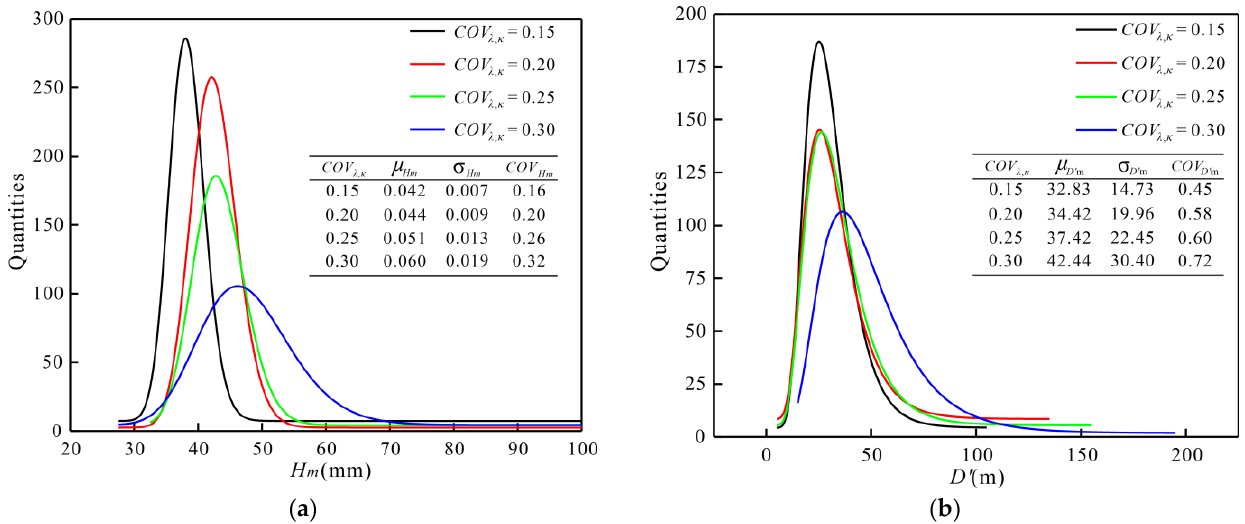
Figure 18. Effect of COV λ , κ on the PDF curves of probabilistic analysis of ground surface settlement of the excavation: ( a ) PDF of H m ; ( b ) PDF of D ’ m .